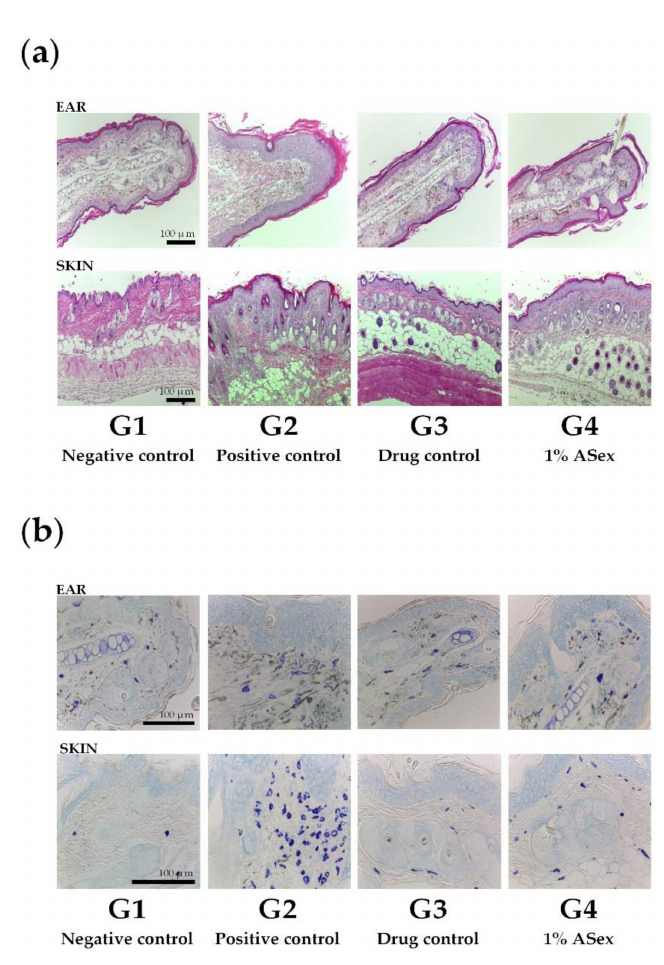
Figure 7. Histological analysis of NC / Nga mice. ( a ) Hematoxylin and eosin staining; ( b ) Toluene blue staining. G1: negative control group; G2: positive control group (HDM only); G3: drug control (0.1% Hc); G4: 1% ASex. All groups were induced with house dust mite ointment except for